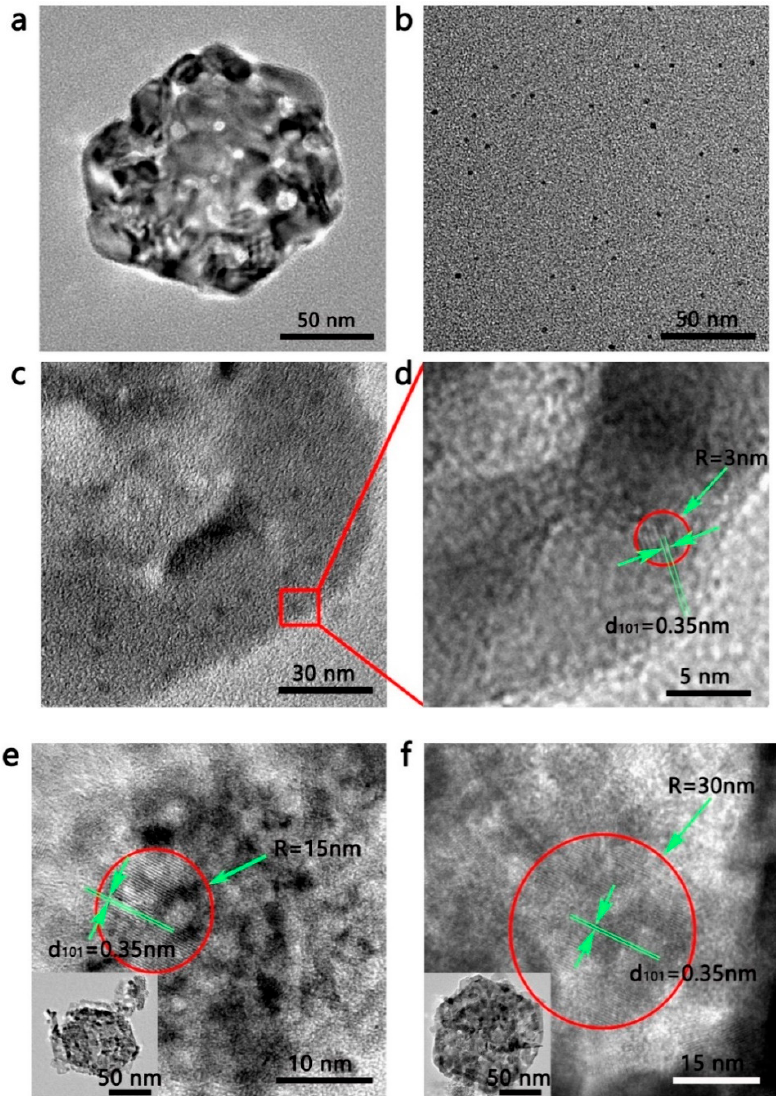
Figure 2. TEM images of ( a ) bare NiO nanosheets, and ( b ) bare TiO 2 QDs. Low- and high-magnification images of ( c , d ) TiO 2 QDs-NiO, ( e ) TiO 2 15-NiO, and ( f ) TiO 2 30-NiO.